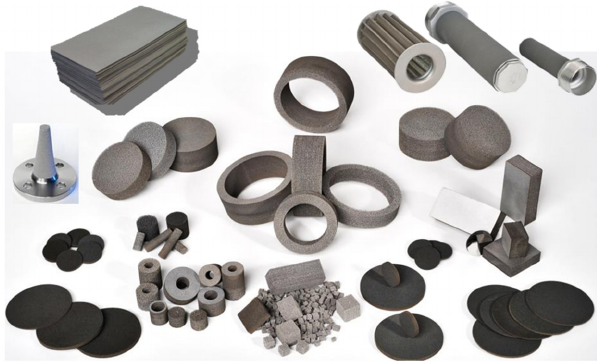
Figure 11. Array of products (filters) for functional applications (courtesy of Alantum).